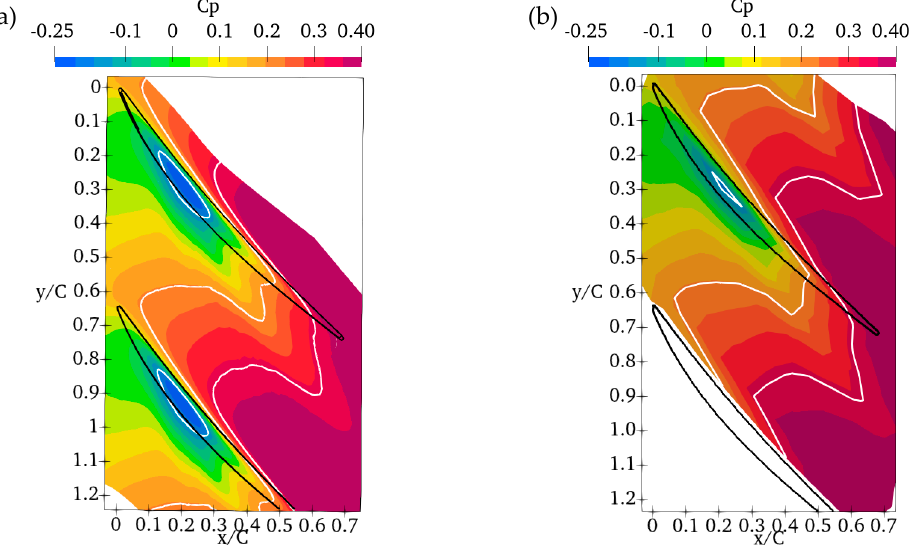
Figure 9. Time averaged pressure coefficient at the endwall ( z = 0 ). Results from ( a ) WRLES and ( b ) experiments [23].